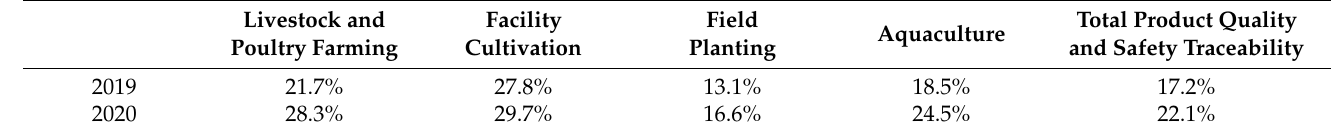
Table 2. Informatization levels of agricultural product quality and safety traceability in